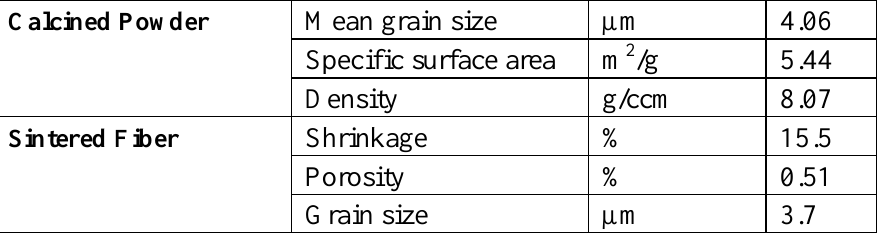
Table 1. The values of calcinations and sintering related coefficients for obtained PLZT